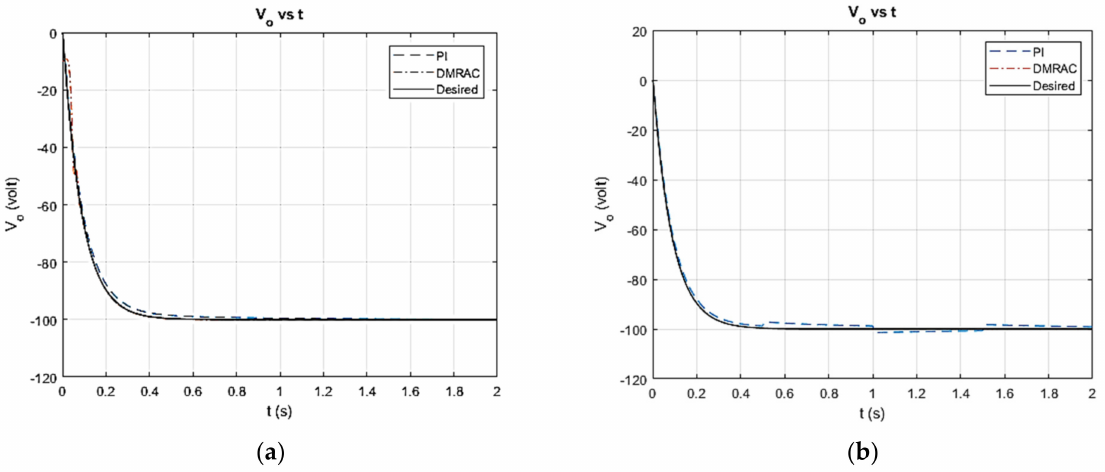
Figure 4. Constant voltage tracking ( a ) without the presence of disturbance and ( b ) in presence of